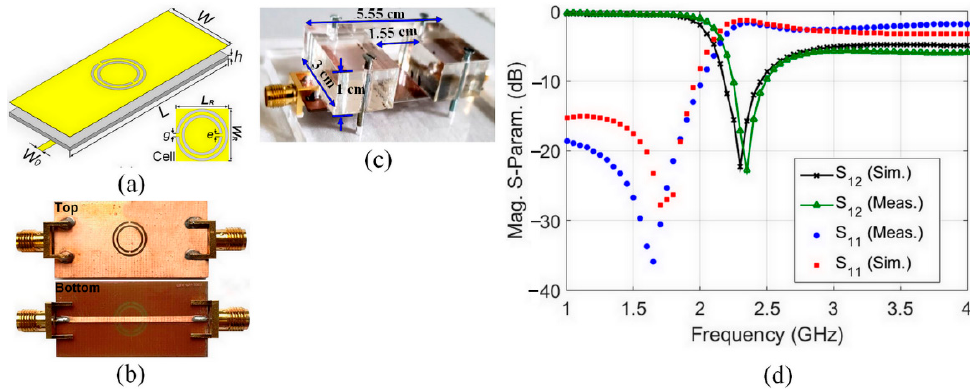
Figure 2. The designed CSRR circuit: ( a ) the geometrical parameters, ( b ) the photograph of the fabricated circuit prototype, ( c ) the geometrical dimensions of the fixture, and ( d ) the measured and simulated S-parameters of the CSRR sensor circuit prior to loading.